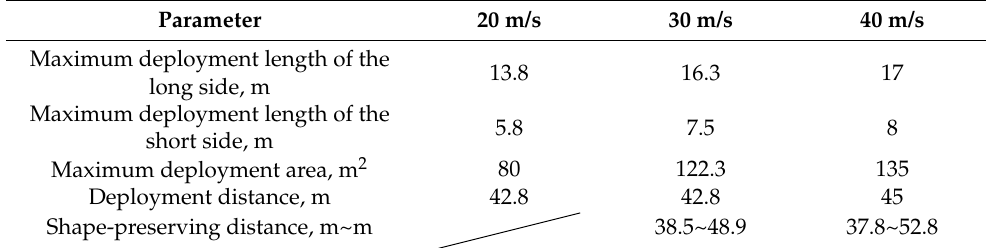
Table 5. Deployment parameters with different launch speeds.